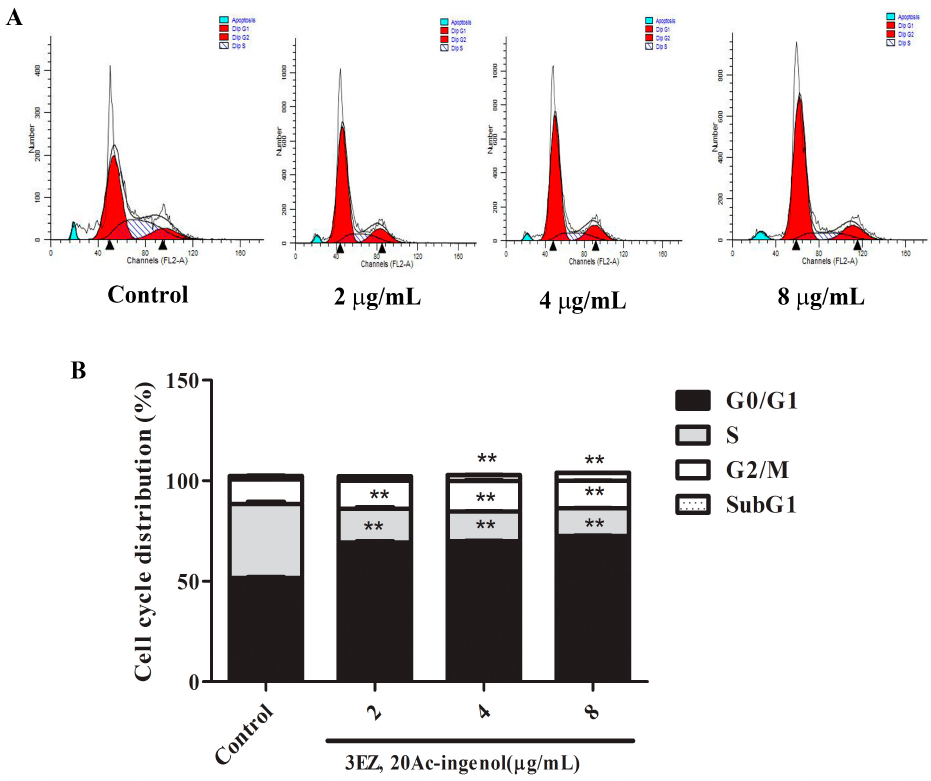
Figure 3. The effects of 3EZ, 20Ac-ingenol on L-O2 cell cycle using flow cytometer: ( A ) cell cycle distribution; and ( B ) cell number percentage in each phase (subG1, G0/G1, S and G2/M) were detected and calculated. Quantification of apoptotic cells were analyzed and expressed. Data are presented as mean ± SD from triplicate samples, ** P < 0.01 compared with control group.